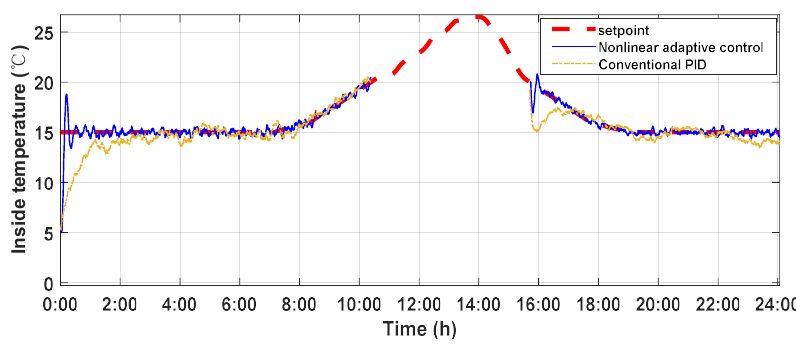
Figure 14. The outside solar radiation of the CSG on 26 January 2018.